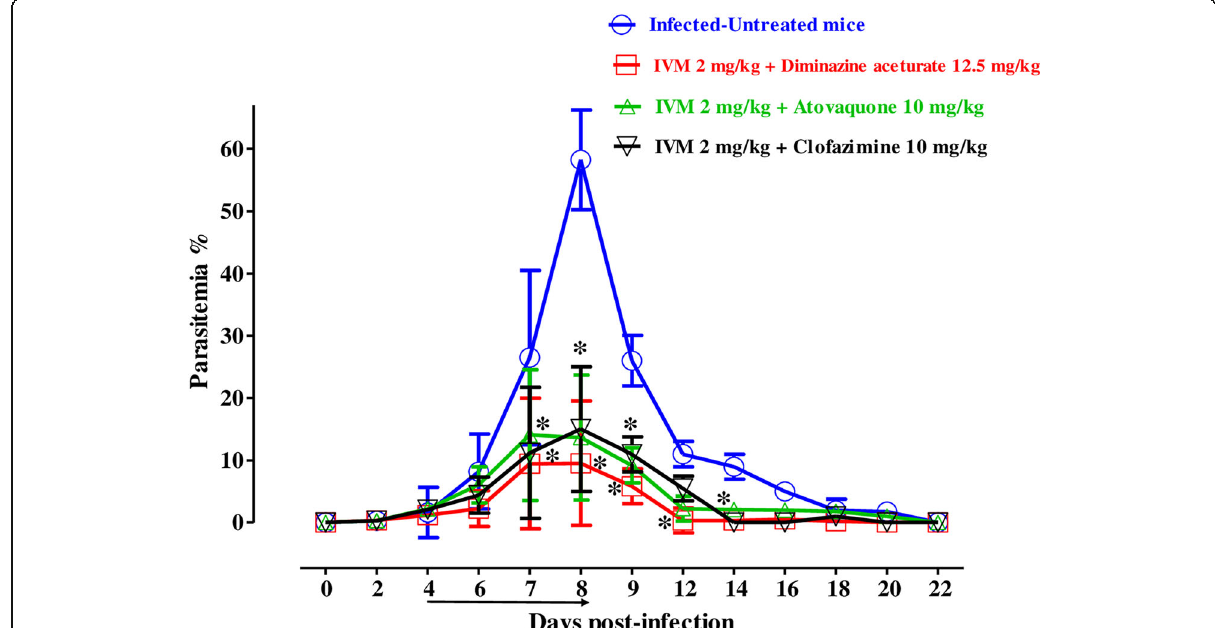
Fig. 4 The growth inhibition of IVM combinations on B . microti in vivo. The graph shows the inhibitory effects of DA, AQ, and CF combined with IVM treatments as compared with the untreated group. The values plotted indicate the mean ± standard deviation for two separate experiments. The asterisks (*) indicate statistical significance ( p < 0.05) based on one-way ANOVA Tukey ’ s test using GraphPad Prism version 5.0 for Windows (GraphPad Software Inc., San Diego, CA, USA). The arrow indicates five consecutive days of treatment. Parasitemia was calculated by counting infected RBCs among 2000 RBCs using Giemsa-stained thin blood